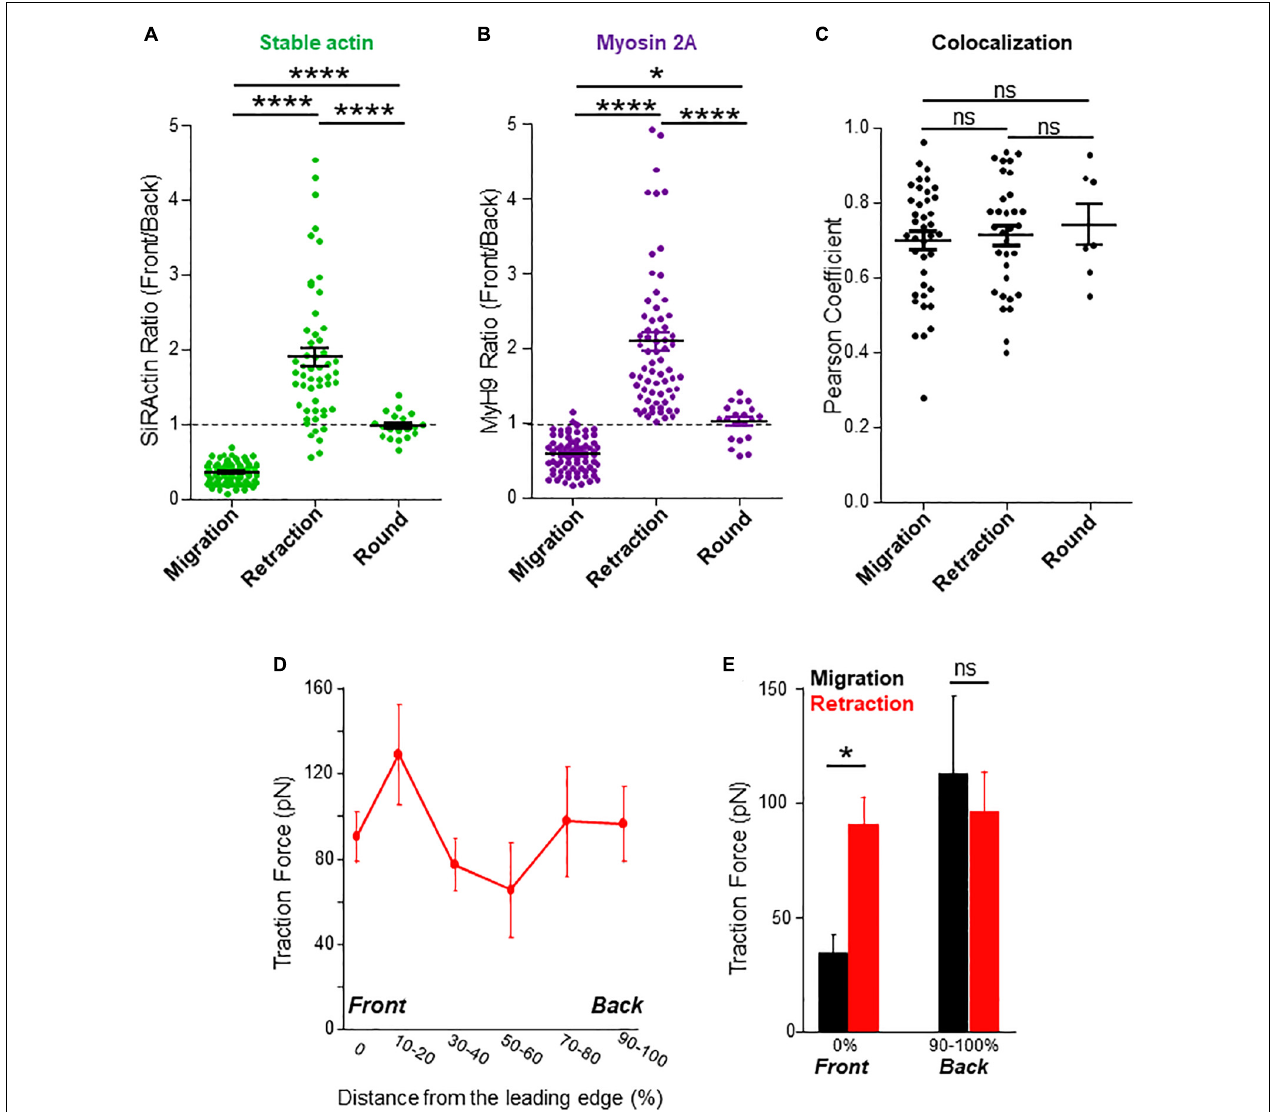
FIGURE 2 | Stable actin relocalization. (A) The front to back ratio of SiRActin intensities were measured by drawing a scanline along the cell axis of cells upon migration, while the lamellipodium retracted and once the cell had rounded up. Values correspond to the mean ± SE of 85 events from 60 different cells (migration), 53 events from 28 different cells (lamellipodium retraction) and 19 rounding events from 16 different cells (after retraction). Statistical analysis was performed through a one way ANOVA test with a Tukey post-test. **** p < 0.0001. (B) The front to back ratio of MyH9-GFP intensities were measured by drawing a scanline along the cell axis of cells upon migration, while the lamellipodium retracted and once the cell had rounded up. Values correspond to the mean ± SE of 77 events from 42 different cells (migration), 69 events from 36 different cells (lamellipodium retraction) and 20 rounding events from 17 different cells (after retraction). Statistical analysis was performed through a one way ANOVA test with a Tukey post-test. **** p < 0.0001, * p < 0.05. (C) In cells transfected with MyH9-GFP and labeled with SiRActin, Pearson coefficient was measured upon migration, while the lamellipodium retracted and once the cell had rounded up. Values correspond to the mean ± SE of 39 events from 24 different cells (migration), 32 events from 21 different cells (lamellipodium retraction) and seven rounding events from seven different cells (after retraction). Statistical analysis was performed through a one way ANOVA test with a Tukey post-test. ns: not significant. (D) Subcellular distribution of forces was measured in CXCL12-stimulated T lymphocytes upon lamellipodium retraction on approximately 700 Pa gels coated with VCAM-1. The values of the forces expressed in picoNewton correspond to the mean of forces ± SE measured in eight different cells retracting their lamellipodium. (E) Comparison of the values of the forces measured in 14 migrating cells (black) or in eight cells retracting their lamellipodium (red) at their front (0%) or their back (90–100%). * p < 0.05 Kruskal-Wallis